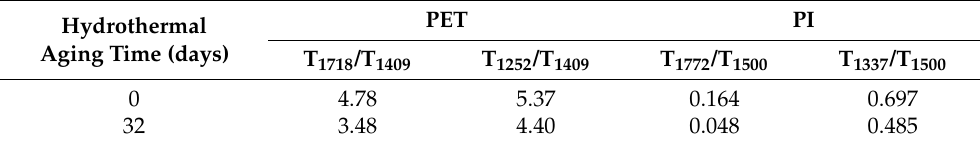
Table 1. Influence of aging time on the ATR-FTIR group content of PET and PI films.